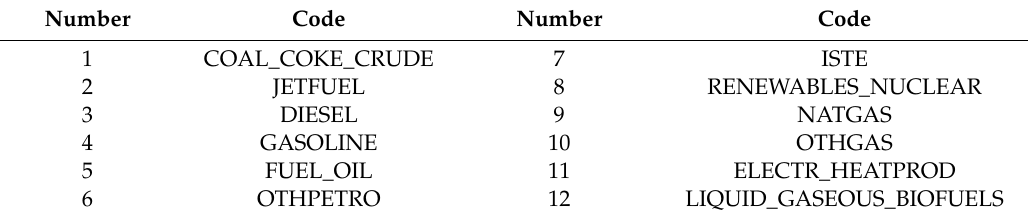
Table A2. 12 energy commodities in WIOD environmental